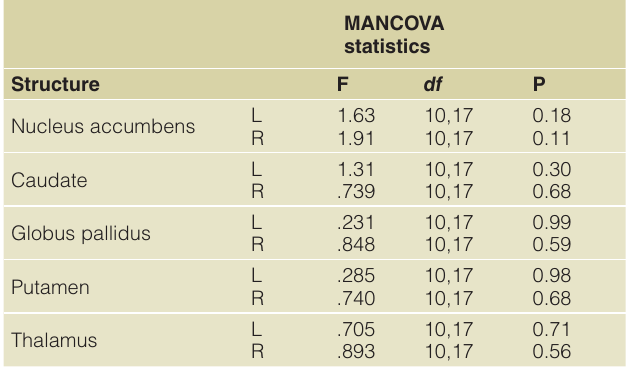
Table 3. Shape comparison of the thalamus and basal ganglia structures (TS vs. control).